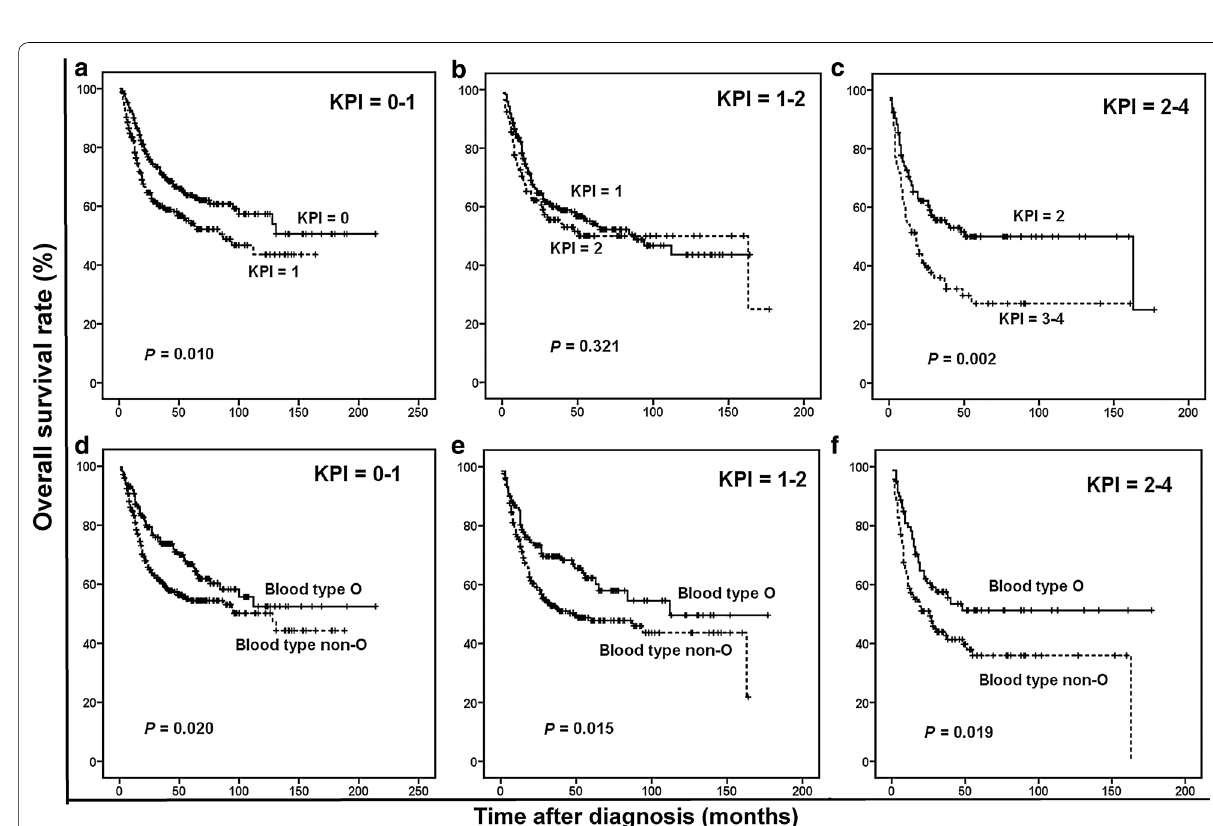
Fig. 3 Survival curves of patients with ENKTL according to the Korean Prognostic Index (KPI) score. a OS curves of patients with KPI score according to the KPI model. b OS curves of patients with KPI score according to the KPI model. d OS curves of patients with KPI score score 1–2 according to blood types O and non‑O. f OS curves of patients with KPI score =